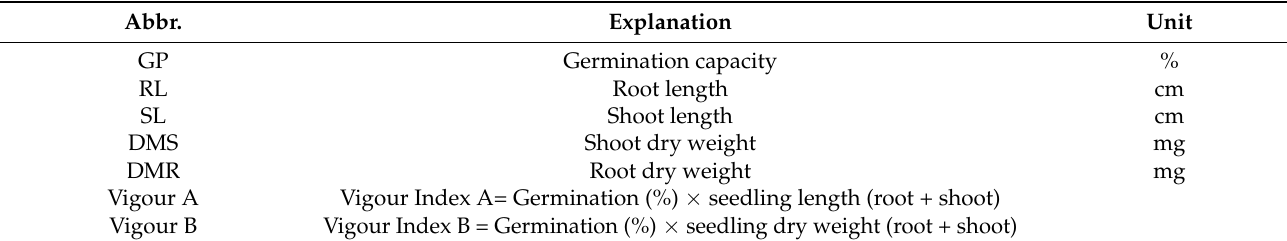
Table 1. Abbreviations and explanations